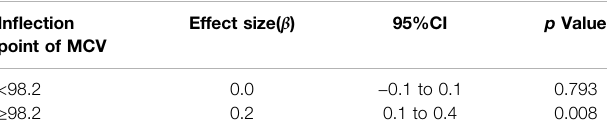
Effect: MELD Cause: MCV adjusted :Sex, Age, Smoking, Drinking, SBP, DBP.